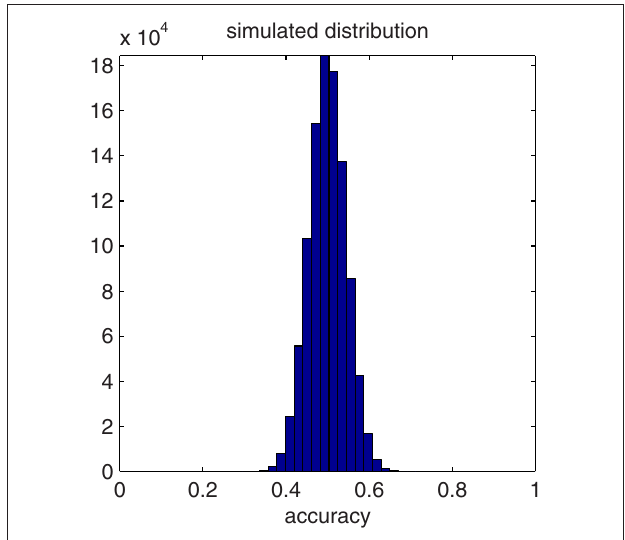
FIguRe A1 | Distribution of classification results under our simulated null